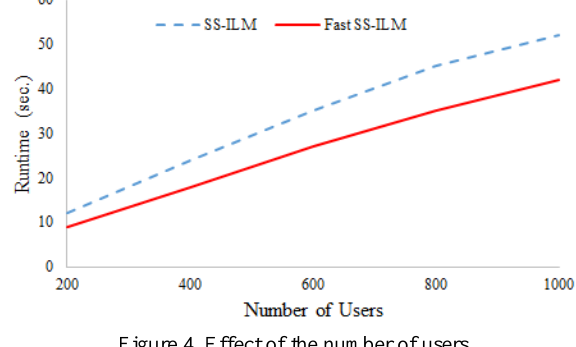
Figure 4. Effect of the number of